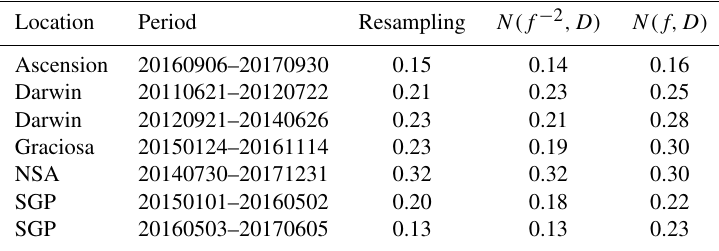
(R) . Values are obtained from (a) resam- f